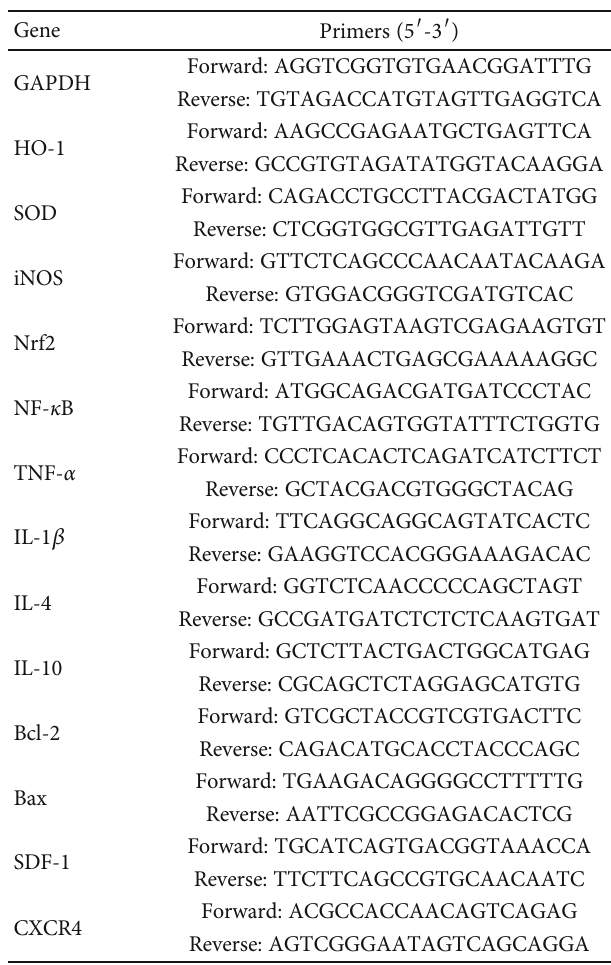
Table 1: Gene-speci fi c primers for qRT-PCR.